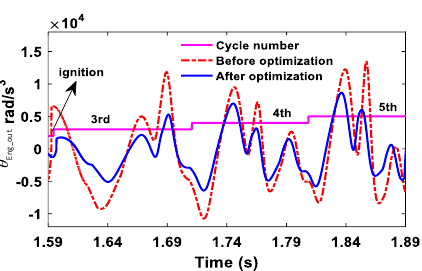
Figure 15. Optimization results of the first three working cycles after ignition.